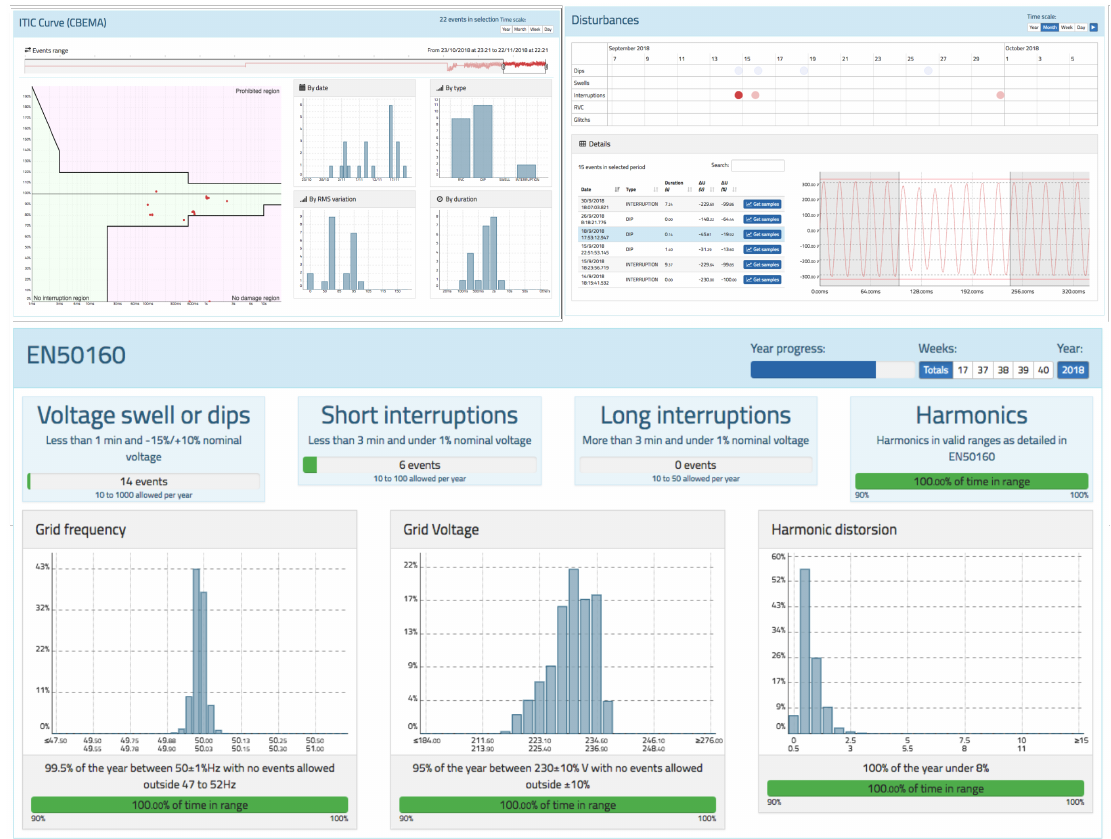
Figure 15. PQ events view of oZm. Top left: information technology industry council (ITIC) curve. Top right: disturbances table and viewer. Bottom: EN-50160 visualization and classification for voltage